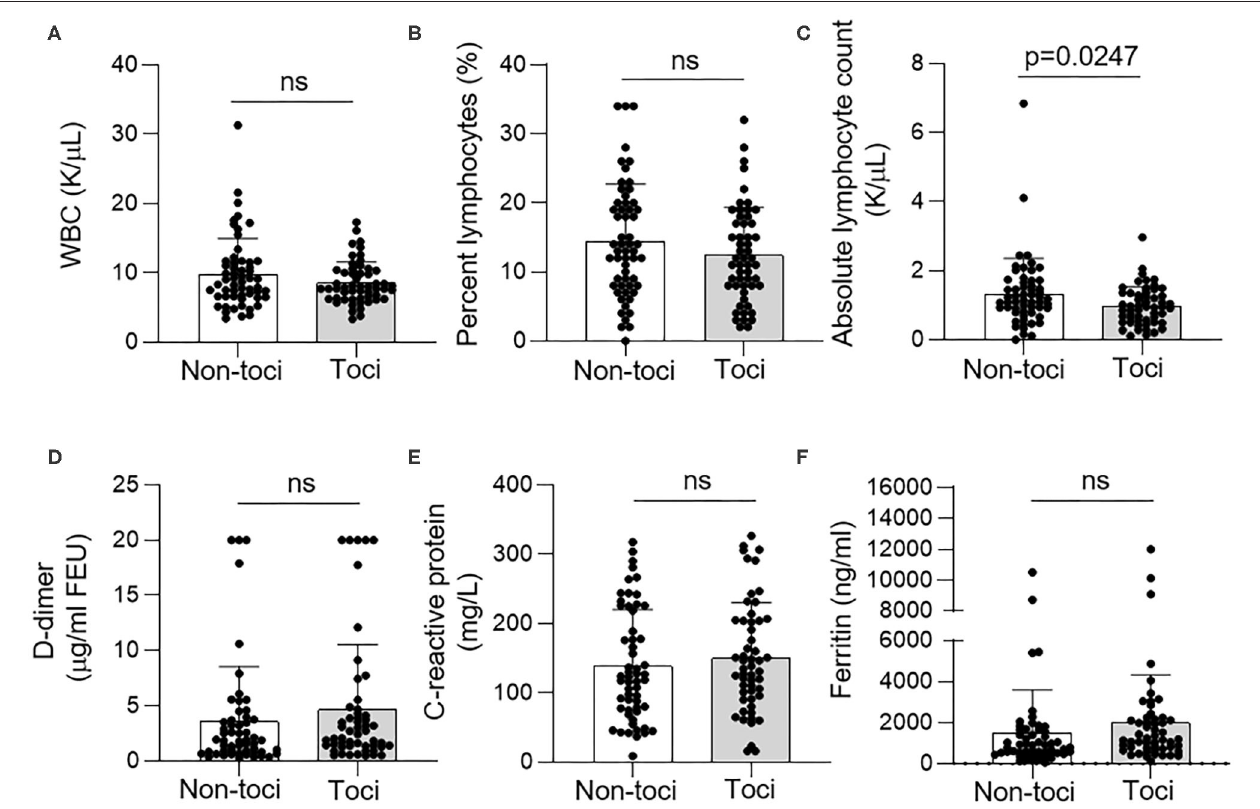
FIGURE 1 | Laboratory data in tocilizumab and non-tocilizumab groups. (A) White blood cell (WBC) count, (B) percent lymphocyte, (C) absolute lymphocyte count, (D) D-dimer, (E) C-reactive protein, and (F) ferritin levels on day 1 of admission to the ICU. There was no difference between non-tocilizumab (non-toci) and tocilizumab (toci) groups in laboratory data except for absolute lymphocyte count, which was lower in the tocilizumab group. ns, not significant.